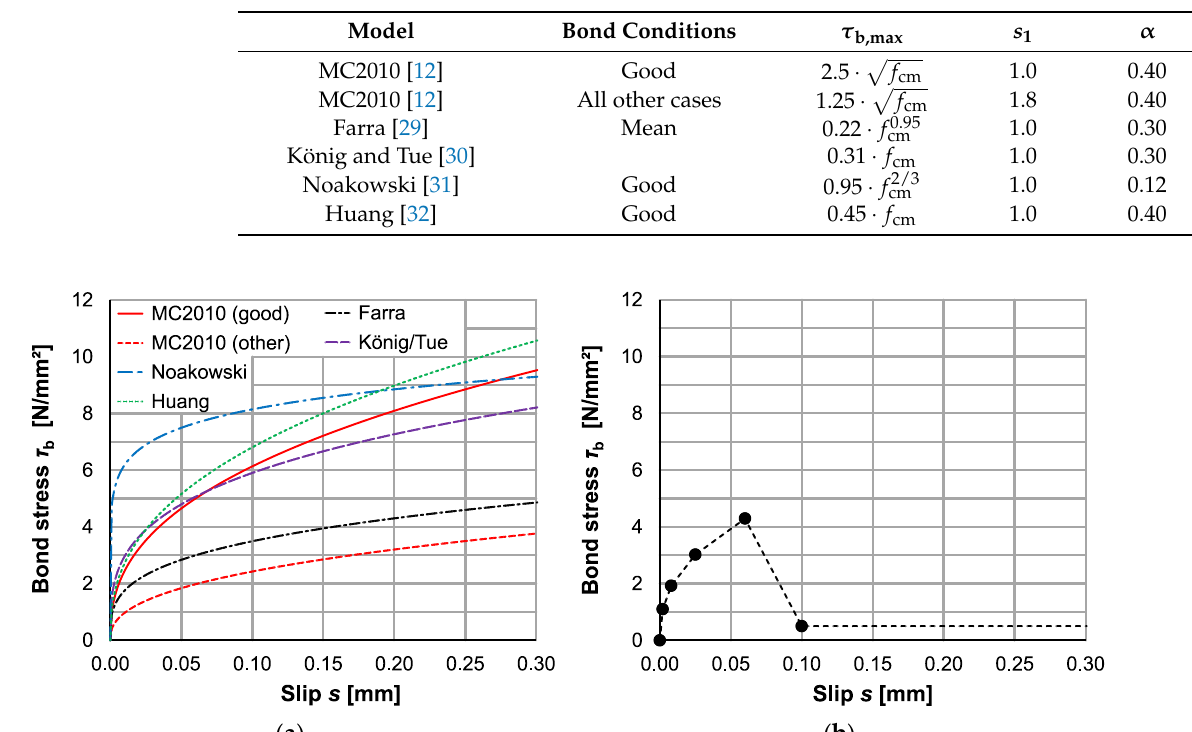
Table 1. Parameters for the ascending branch of the bond–slip relationship for normal-strength concrete. Model